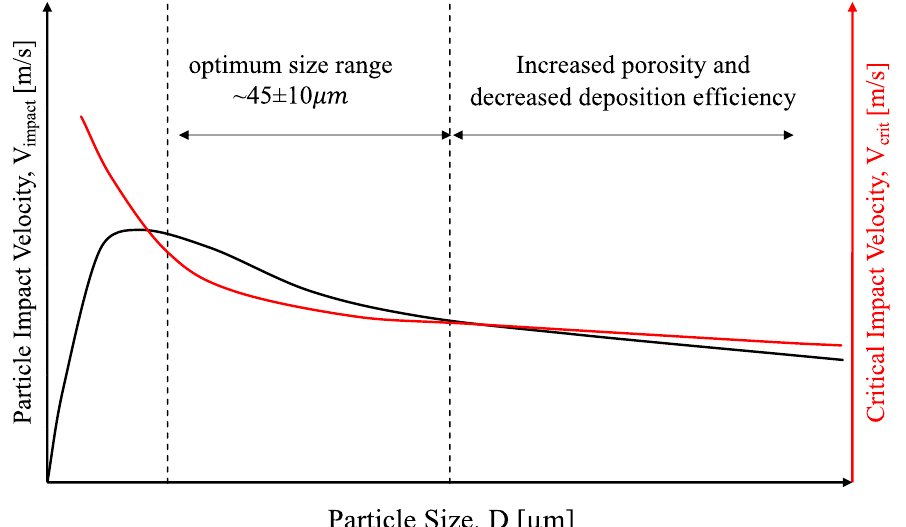
Figure 5. Effect of particle size distribution on the particle impact velocity during a cold spray dep- osition